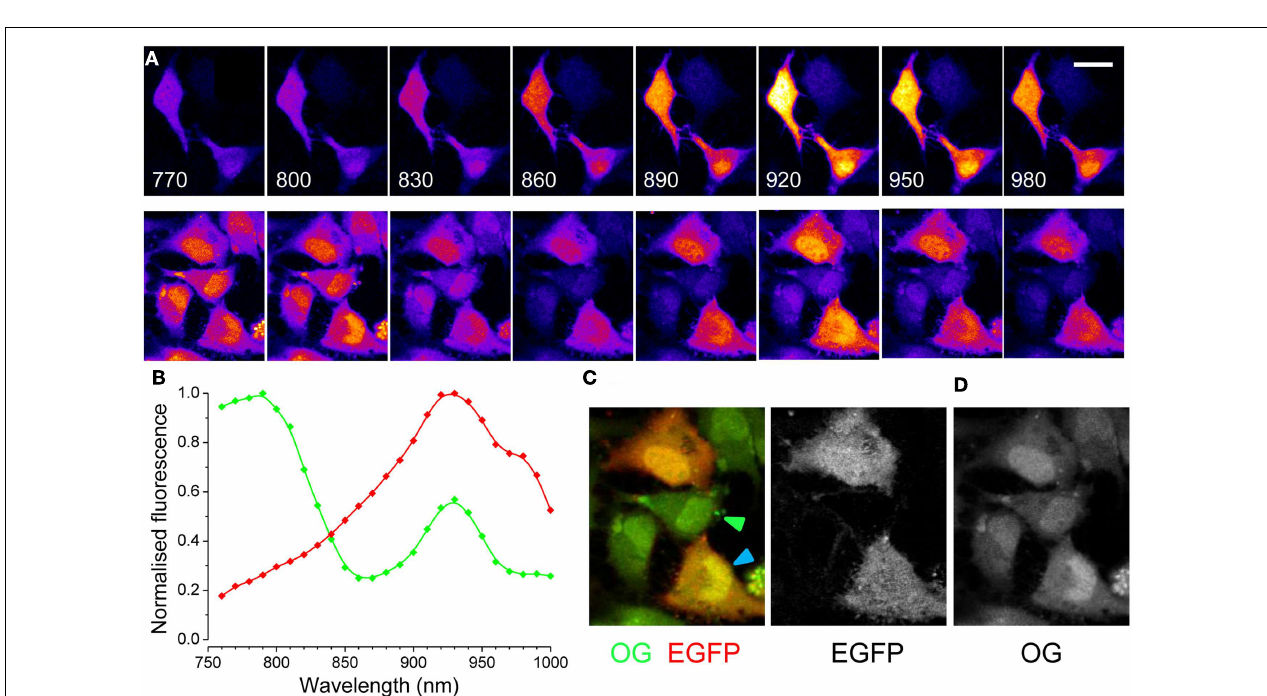
spectra. (B) Excitation spectra of EGFP (red, n = 4) and of OG (green, n = 3). The spectra of OG did not change with Ca 2 + concentration, if not for a linear scaling (not shown). (C) Synthetic RGB image obtained by presenting the image excited at 790 nm in the green channel and the image excited at 930 nm in the red channel. (D) Spectral linear decomposition has been used to separate the contribution to fluorescence of EGFP and